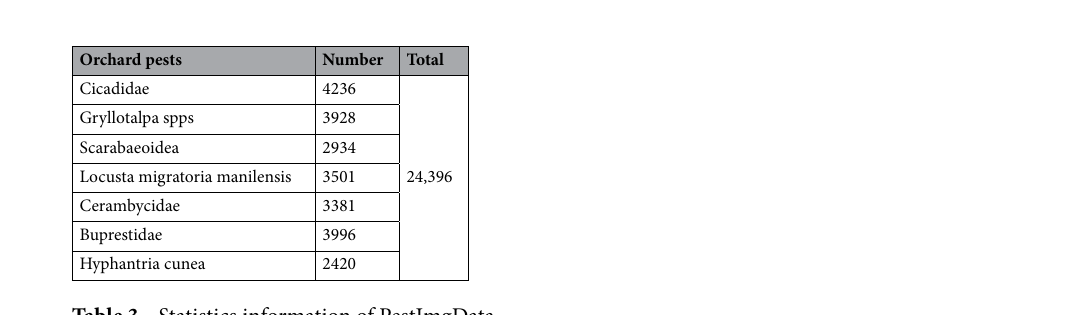
Table 3. Statistics information of PestImgData.